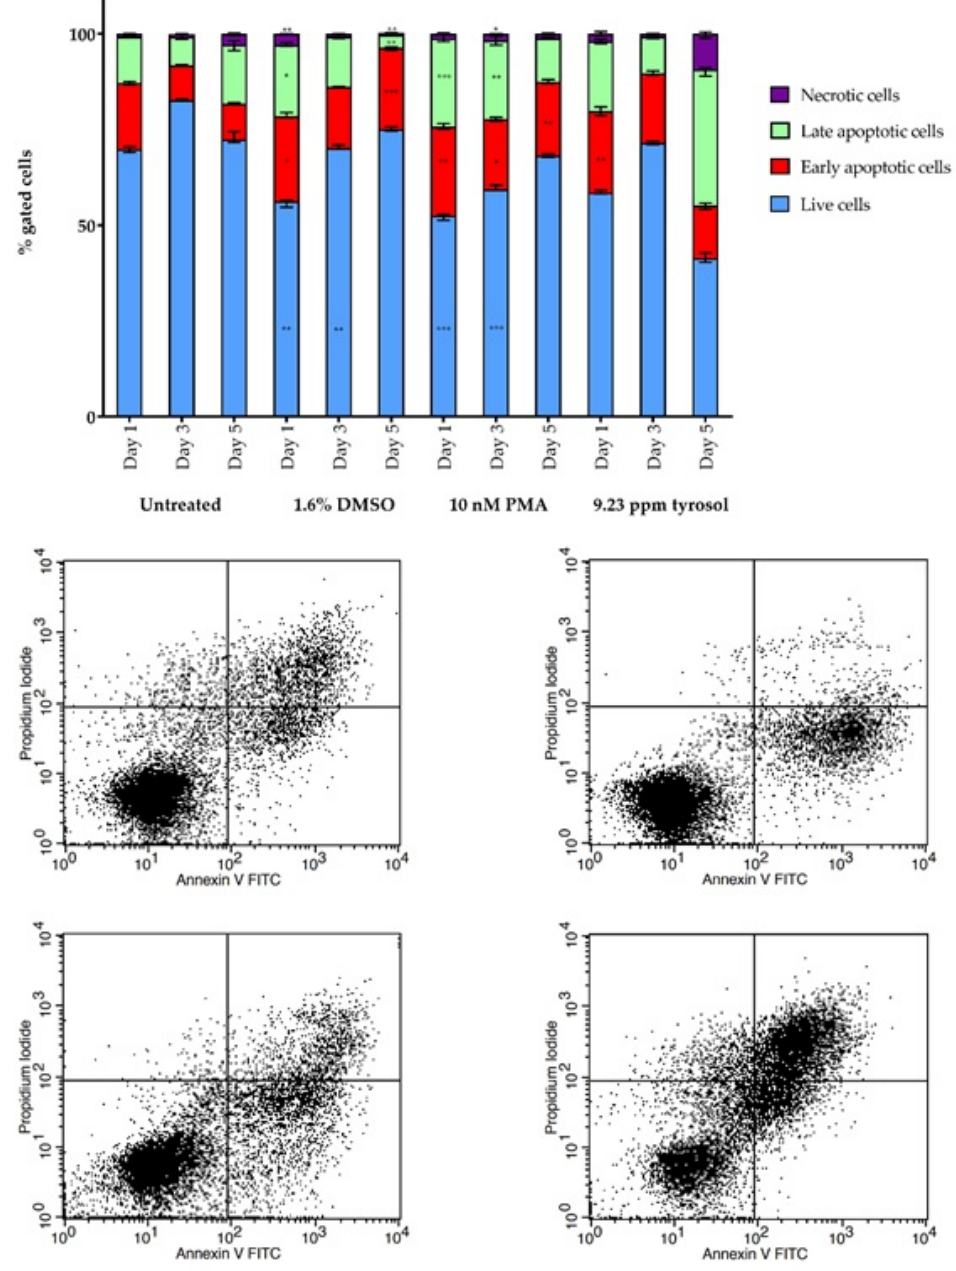
Figure 7. Percentage gated live, early apoptotic, late apoptotic and necrotic HL-60 cells on day 1, day 3, and day 5 and representative quadrants for each condition on day 5. Days 3 and 5 and representative histogram overlays and